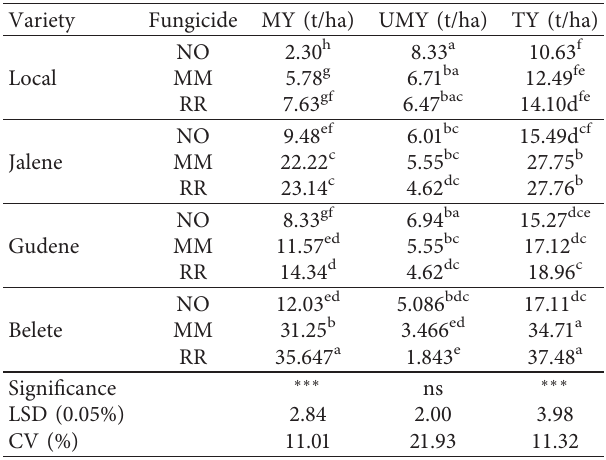
Table 5: Interaction effect of different fungicides application and potato varieties on yield and yield components.